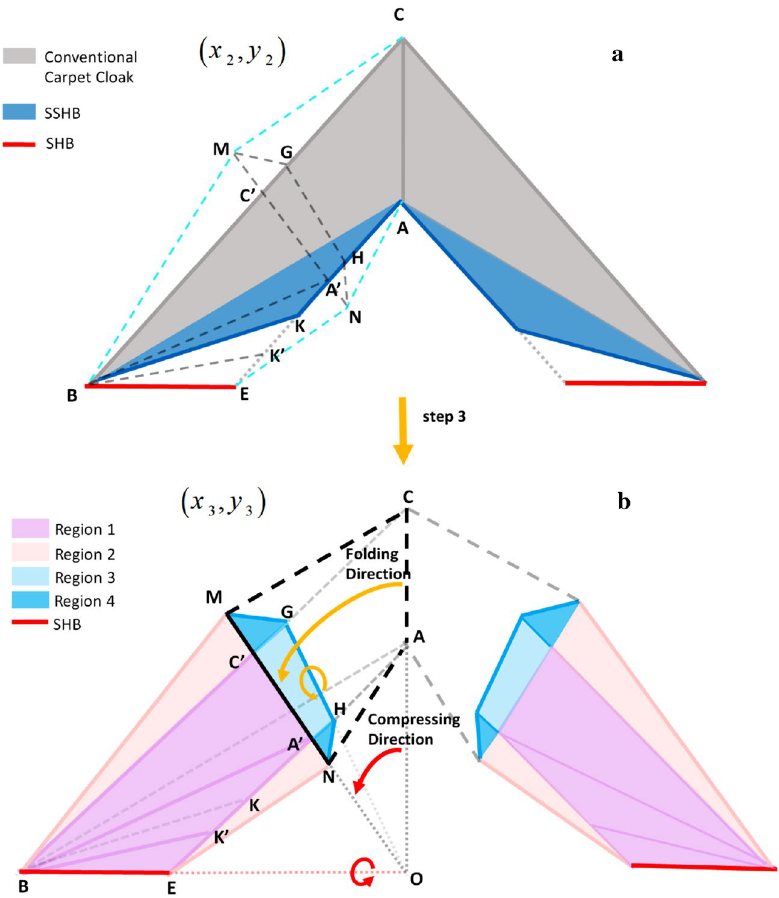
Figure 4. Schematic diagram of the proposed object independent non-closed carpet cloak. ( a ) Carpet cloak with SSHBs. In order to make a window on this structure, the trapezoidal region AEBC and its surrounding fluid (dashed light blue lines) in the reference space (x 2 ,y 2 ) are going to be compressed to smaller domains. ( b ) Non-closed carpet cloak. The trapezoidal domain AEBC , is compressed to the smaller purple trapezoid denoted by region 1 in real space (x 3 ,y 3 ) and the surrounding host medium, is also compressed to the melon domains named region 2. Blue domains show the complementary materials. The black dashed line boundaries represent the original boundaries before compressing. The incident wave that meeting the dashed lines, is routed to the solid lines by complementary domains denoted by regions 3 and 4. Significant result of this transformation is that the signature of the created window on conventional carpet cloak is canceled. Therefore, the whole structure is matched to host fluid and acts like an illusionary single reflecting